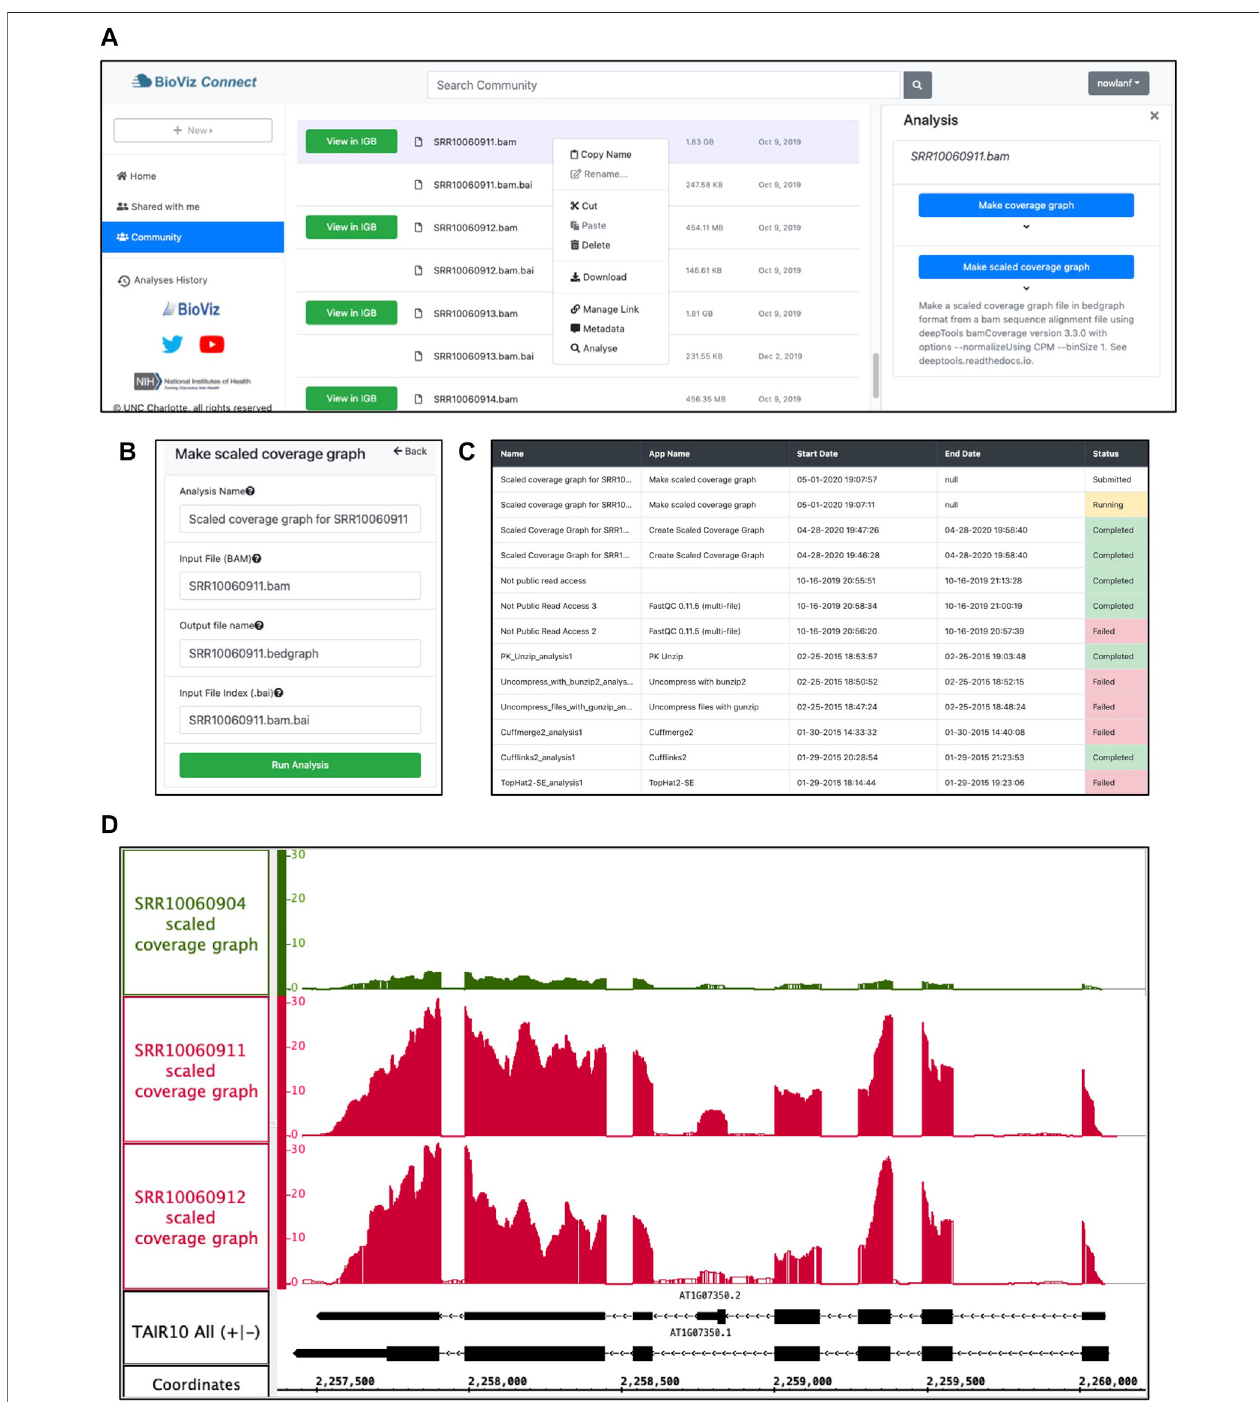
FIGURE 4 | Example analysis in BioViz Connect with output visualized in IGB. (A) BioViz Connect main page with analysis right panel open. (B) Scaled coverage graph analysis options for naming the analysis, selecting input fi le, output fi le name, and index fi le selection. (C) Analyses History showing the status of current and previous jobs. (D) SRR10060904 (control), SRR10060911 (heat treated), and SRR10060912 (heat treated) scaled coverage graphs viewed in IGB overlapping the SR45a gene of A. thaliana .